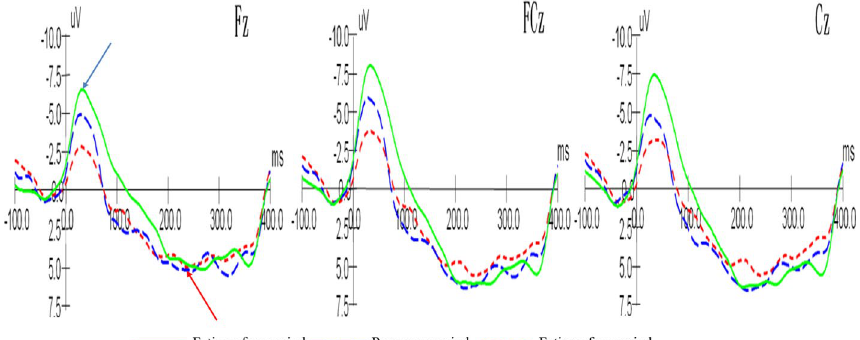
Fig. 2 Waveforms of ERN and early Pe in three time periods for Fz, FCz, Cz